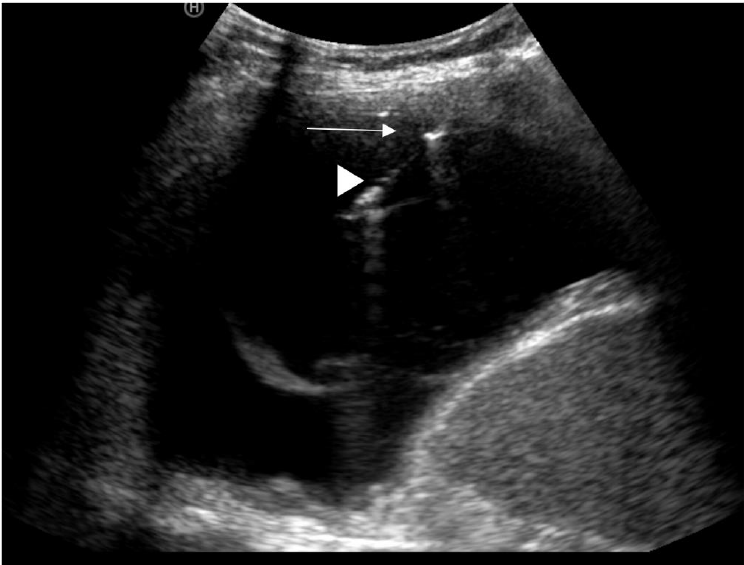
Diagnostics 2020 , 10 , 1046 Figure3. ImageofaUS-guidedneedlebiopsy; whitearrowhead = needle,whitearrow = pleuralthickening. Figure 3. Image of a US-guided needle biopsy; white arrowhead = needle, white arrow = pleural thickening .